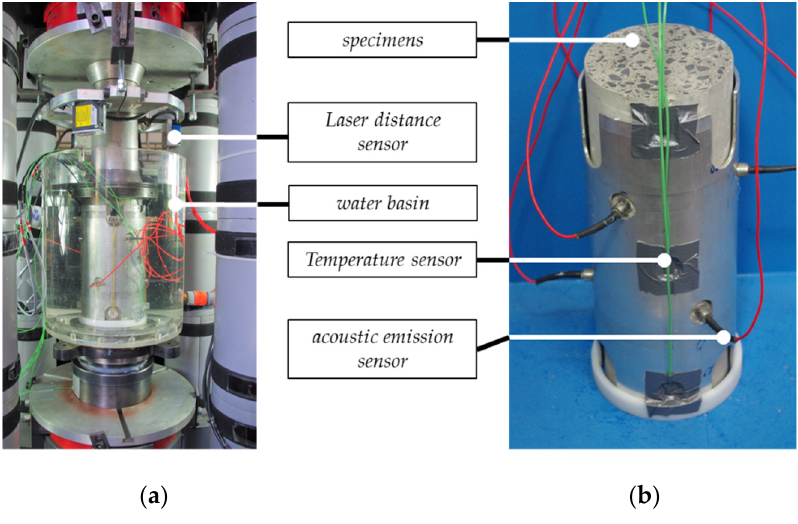
Figure 1. Experimental set-up ( a ) and measurement equipment ( b ). Table 3. The number of fatigue